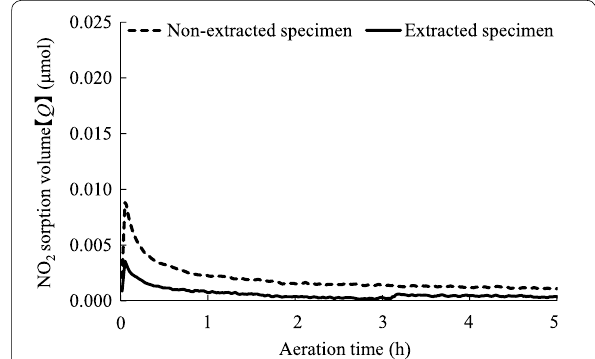
Fig. 4 Variation over time in NO 2 sorption volume, Q in non-extracted and extracted specimens under natural drying. The moisture content in the specimens was 0%. ( n